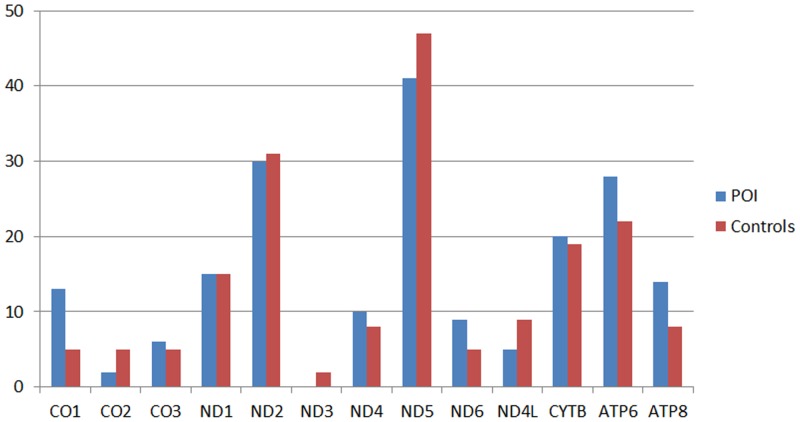
Nonsynonymous variations in different mitochondrial genes.The X axis was the mitochondrial gene name. The Y axis was the sample numbers which have nonsynonymous variations.